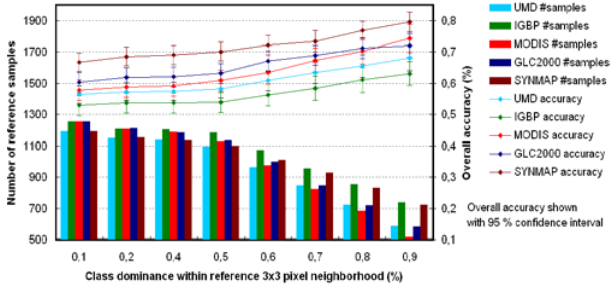
Figure 4. Relationship of HRP, overall accuracy and number of used samples